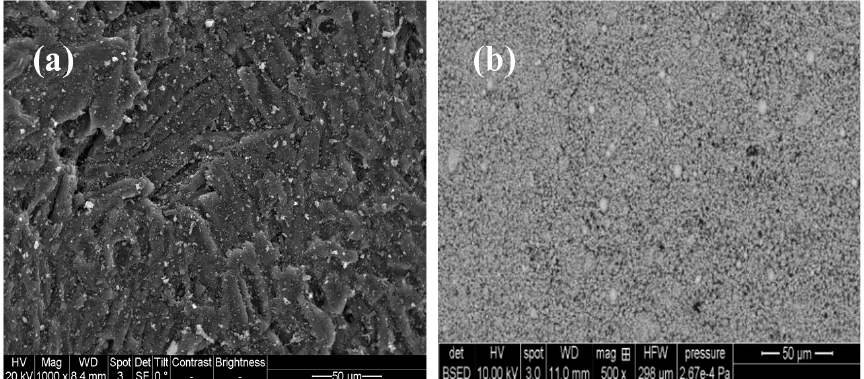
Figure 1. SEM images of granular activated carbon ( a ) and nZVI ( b ).